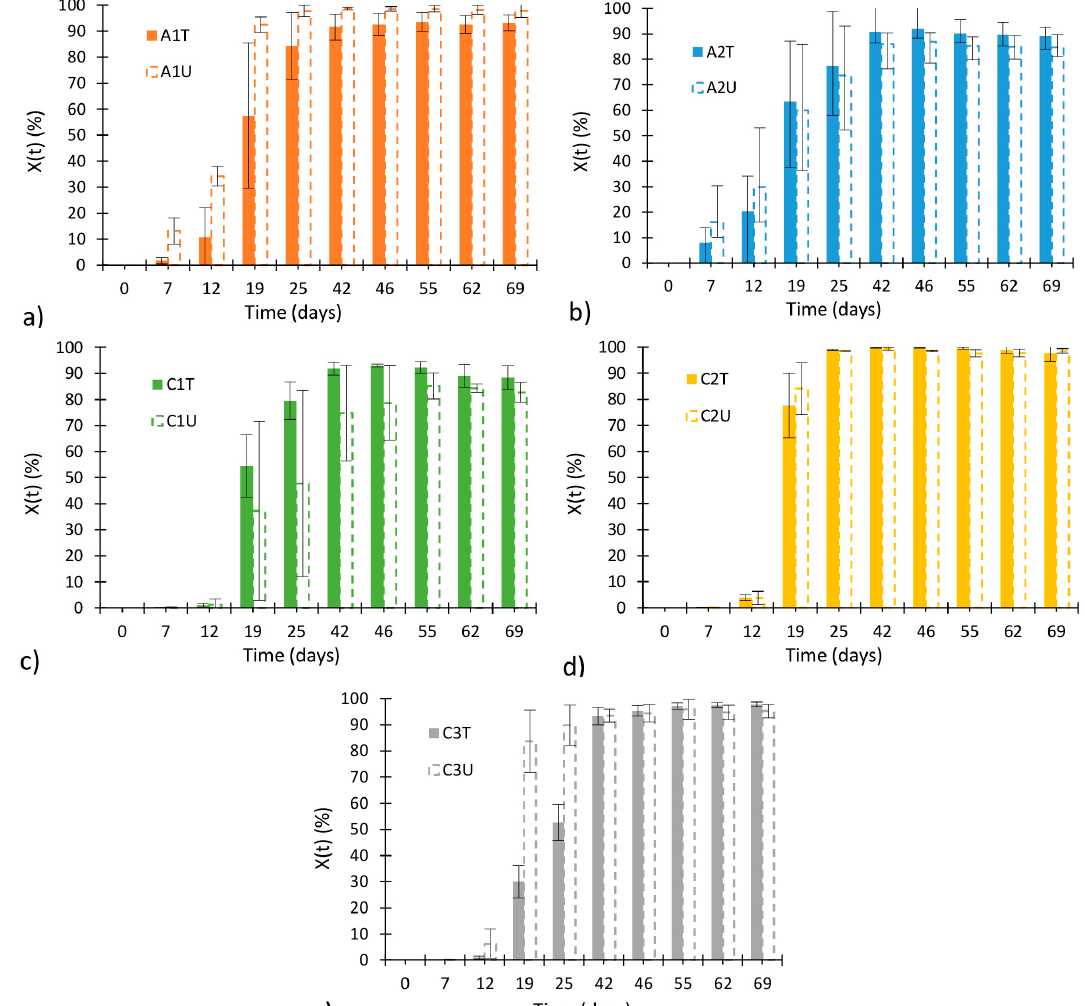
Figure 2. Algal coverage evaluated by digital image analysis (DIA): ( a ) A1 specimen; ( b ) A2 specimen; ( c ) C1 specimen; ( d ) C2 specimen; ( e ) C3 specimen. Treated stones (marked with T) and controls (marked with U) of each group were reported in each plot. Vertical bars indicate standard deviation.